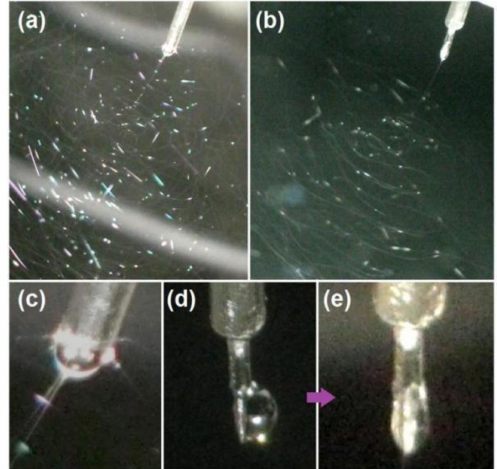
Figure 5. Working process. ( a ) Digital photograph of the traditional working process based on a metal capillary as the spinneret. ( b ) Digital photograph of the working process based on the concentric spinneret with solid Teflon rod. ( c ) Digital Taylor cone. ( d , e ) Change in the liquid droplet to Taylor cone on the Teflon tip under an applied voltage of 7.6